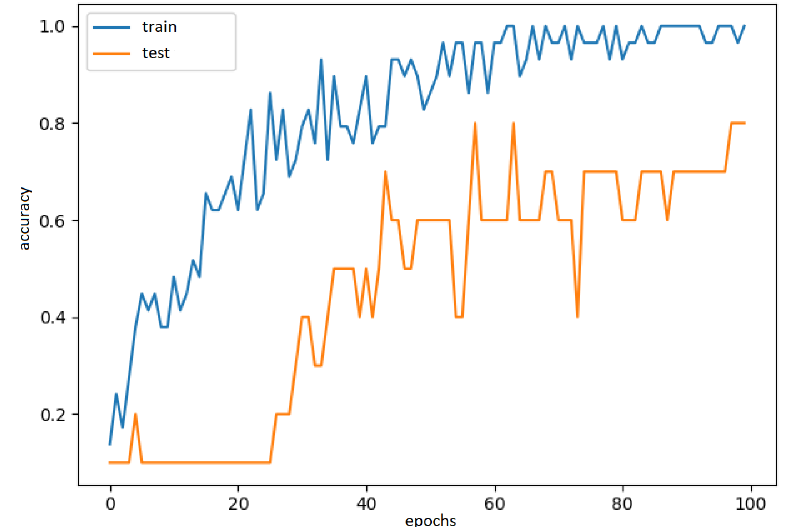
Figure 10. Training and test accuracies of CNN-based handwritten Arabic digit recognition system by epochs are shown. The local dataset is separated to 80% training and 20% test